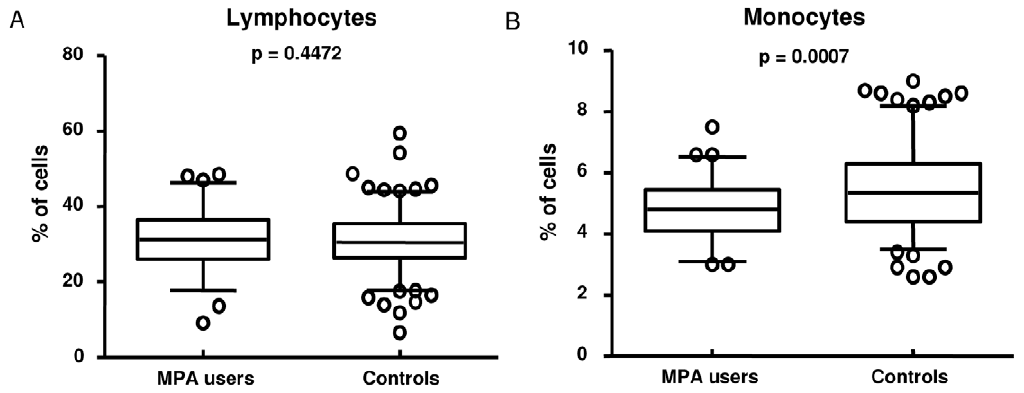
Figure 6. Differential cell counts of MPA users and control participants. Blood was drawn from each study participant (65 MPA users and 163 controls) and the counts determined by the National Health Laboratory Service. Statistical differences were determined by the non-parametric Mann-Whitney test and represented as means and 95%CI.